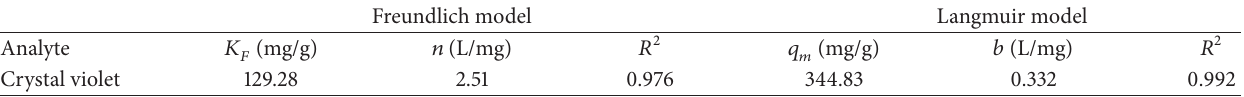
Table 1: Adsorption isotherms’ parameters of